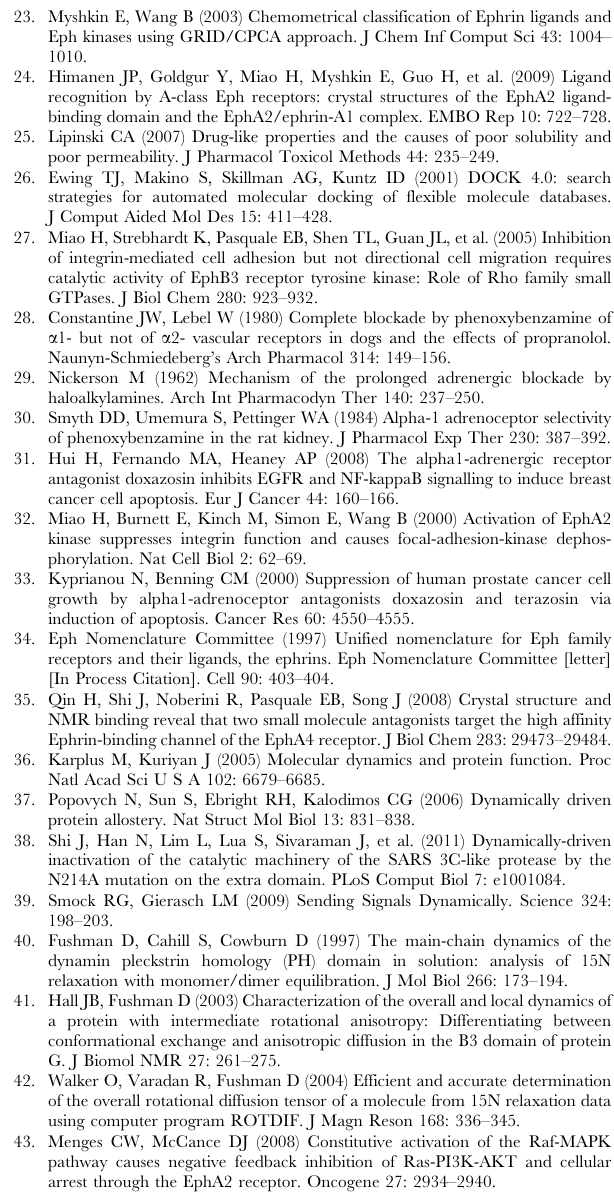
red while ones with negative values in blue. (B) R ex values derived from the model-free analysis of the relaxation data. Data for the free EphA4 LBD are colored in blue while those for the EphA4 in complex with doxazosin are colored in red. (TIF) Figure S7 Inhibition of chemotactic cell migration of PC3- DAB2IP KD, A172-A2, and SCP3-231 cells upon doxazosin treatment. PC3-DAB2IP KD, A172-A2, and SCP3-231 cells were subject to chemotactic cell migration toward 15 ng/ml hepatocyte growth factor (HGF) as described previously (see Methods S1). HGF and doxazosin at indicated concentrations were presented in the lower chamber of the Transwells. Cells were allowed to migrate toward HGF for 5 hours. Data represent average numbers of migrating cells from 6 randomly selected fields. DMSO was used as vehicle control.